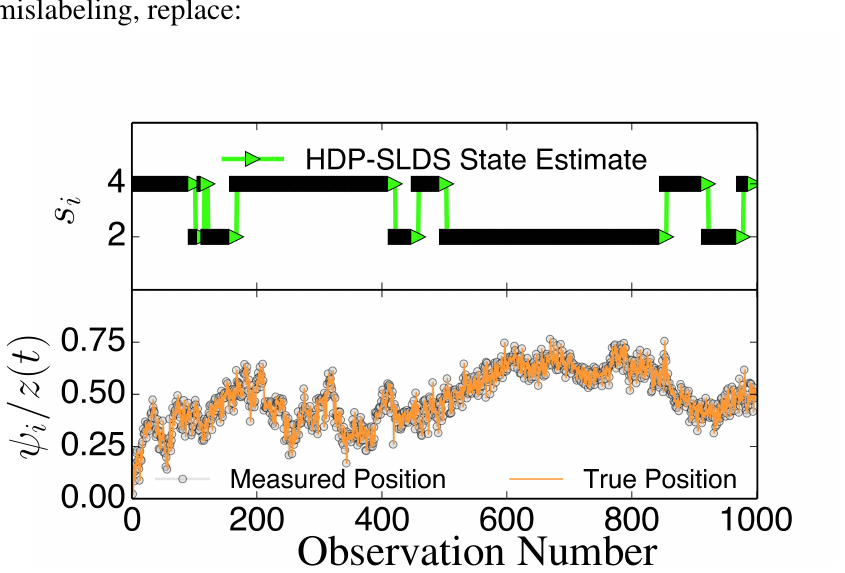
Figure 1. Illustration of abrupt changes in (cid:126)µ . The bottom panel displays the z component of the unobservable state (orange solid line) and the noisily measured values ψ (grey circles). z The top panel illustrates the inferred states s . In this trajectory, there are only two underlying i states that differ in their (cid:126)µ value; an abrupt change in (cid:126)µ induced by a state change causes z to slowly drift towards a fixed point dictated by the (unobserved) (cid:126)µ associated with the state (the magnitude of the drift or “mean reversion rate” depends on the distance of z for the fixed